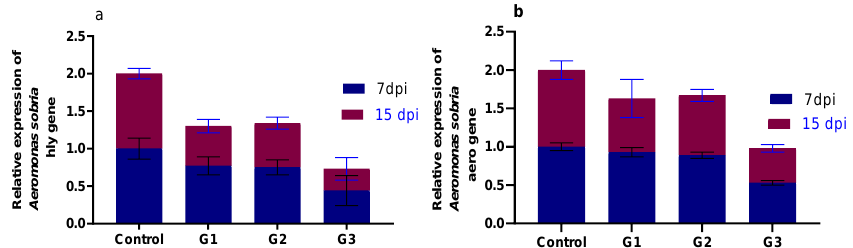
Figure 5. Effect of diets fortified with Thy and/or ThQ at 7 and 15 days post challenge with Aeromonas sobria on relative mRNA expression levels of Aeromonas sobria virulence genes; hly ( a ) and aero ( b ). Results are expressed as means ± SEM. Control: tilapia fed basal diets without any supplementations, G1: tilapia fed basal diets with thymol (Thy) supplementation at a concentration of 200 mg/kg diet, G2: tilapia fed basal diets with thymoquinone (ThQ) supplementation at a concentration of 200 mg/kg diet, G3: tilapia fed basal diets with Thy/ThQ supplementation at a concentration of 200 mg/kg diet each, and dpi: days post infection.